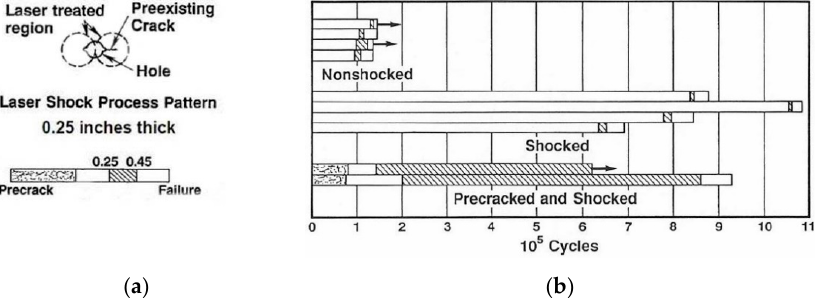
Figure 12. The effect of laser shocking around holes to mitigate crack initiation and propagation in 2024-T351 6mm thick plate: ( a ) the laser shock pattern around the hole; ( b ) test results. The cross-hatched portions are the cycles for the longest crack to increase from 6 to 11 mm long from the center of the hole (0.25 inches = 6 mm) [29].